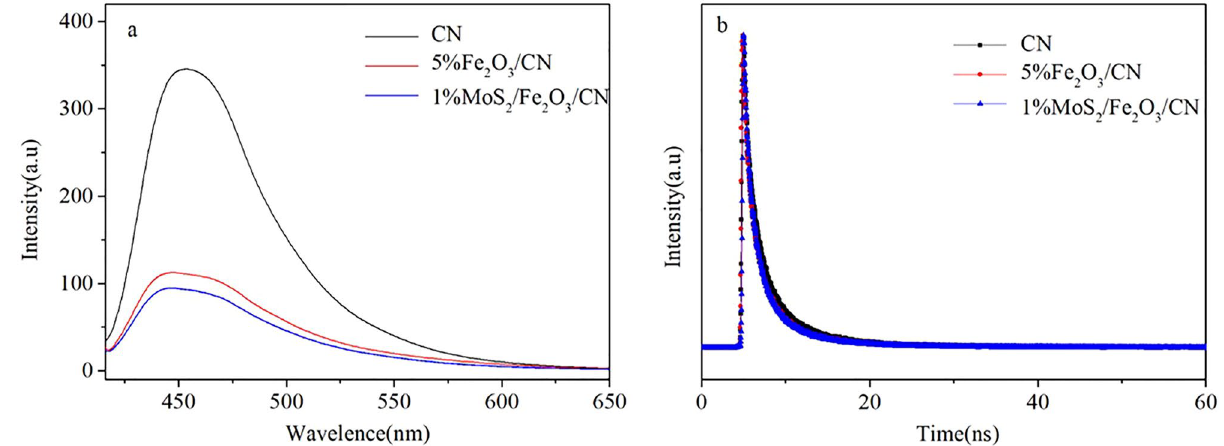
Figure 8. The PL spectrum ( a ) and fluorescence decay curves ( b ) of CN, 5%Fe 2 O 3 /CN and 1%MoS 2 /Fe 2 O 3 /CN.